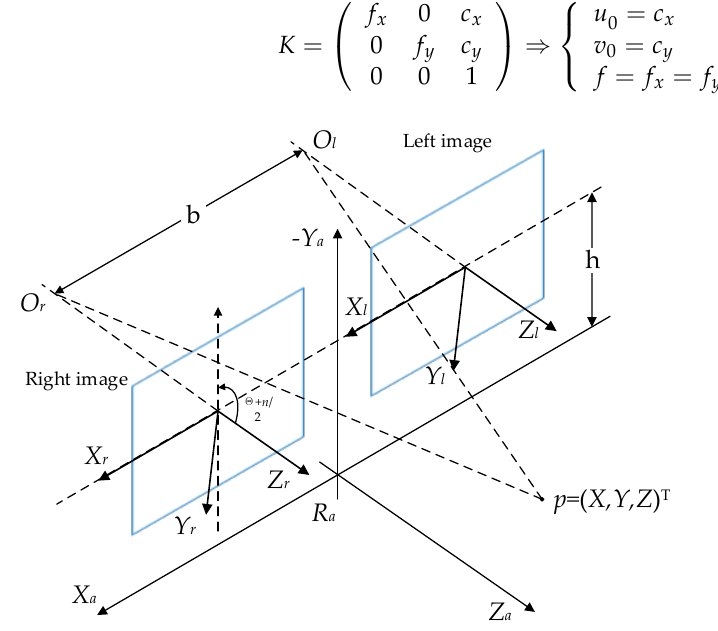
Figure 1. Stereo vision system.